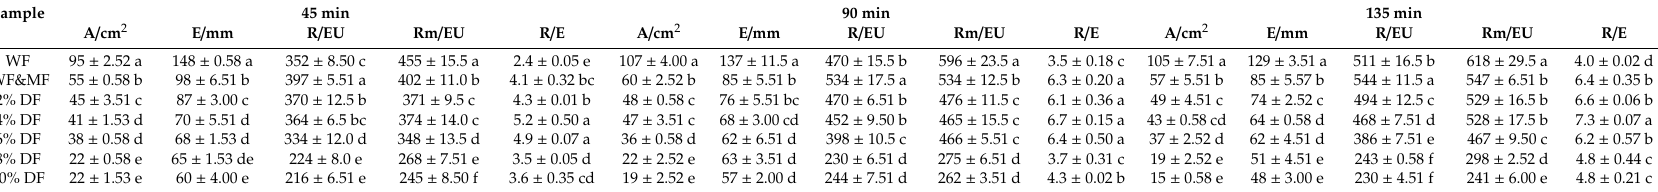
Table 2. Extensographical properties of mixed dough ( n =